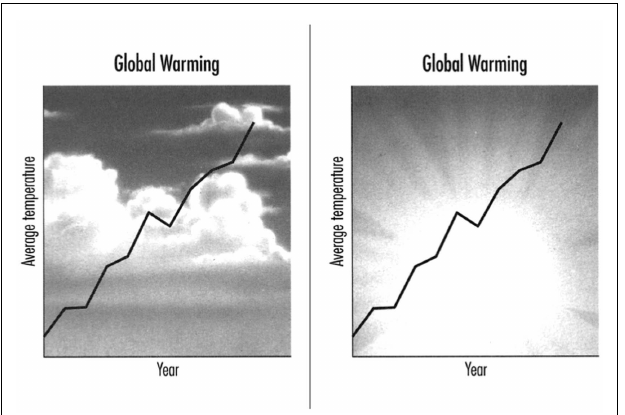
FIGURE 2 | Example of a slide pair viewed by participants in Study 3 (illustrating the principle of Compatibility). Prior to seeing this pair, they received the question, “Which slide does a better job of using a background pattern?”The correct answer for slide choice is the panel on the right. An example of a correct explanation is, “the topic of the chart is global warming, which is better represented with a sun than with clouds;” an example of an incorrect explanation is, “the right has more of an apocalyptic